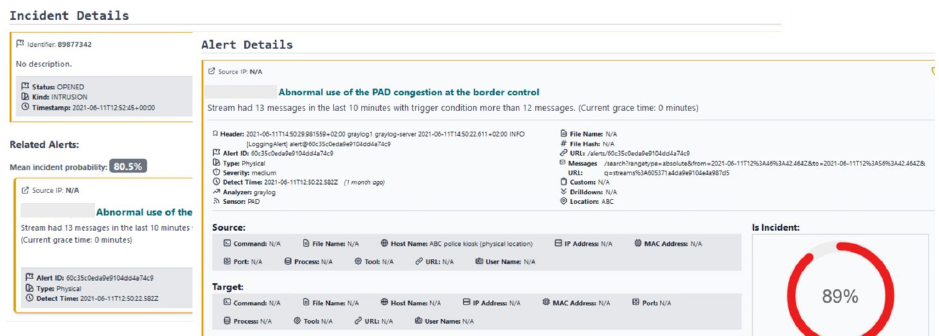
Figure 18. SMS-I Intelligent Dashboard: Incident and Alert details example.